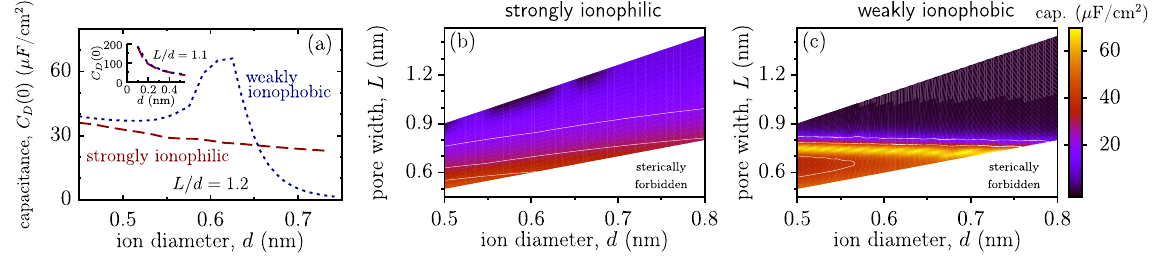
ð 0 Þ , as a function of ion diameter ( d ¼ d δ E ¼ 25 k T ) and FIG. 5. (a) Capacitance at zero voltage, C (cid:3) ) for weakly ionophobic ( D B T ) pores calculated using mean-field theory (MFT). The ratio between the pore width and the ion strongly ionophilic ( δ E ¼ 10 k B ð 0 Þ for small ions with d ≲ 0 . 5 nm and L=d ¼ 1 . 1 . For such ultra narrow pores, diameter is fixed to L=d ¼ 1 . 2 . The inset shows C D ð 0 Þ is practically independent of ionophobicity (for the values of δ E used in this plot). This is because the image forces [see Eq. (A9) C D in Appendix A 3] overcompensate δ E for slit widths L ≲ 0 . 55 , making the pores completely filled with ions. (b,c) Capacitance map for strongly ionophilic and weakly ionophobic nanopores and room-temperature ionic liquids (with d ≳ 0 . 5 nm) in the plane of ion diameter ( d ) and the pore width ( L ) calculated using MFT. This figure suggests a “ two-step optimization strategy, ” in which an ionophobicity-dependent optimal pair ( d , L ) exists that maximizes the differential